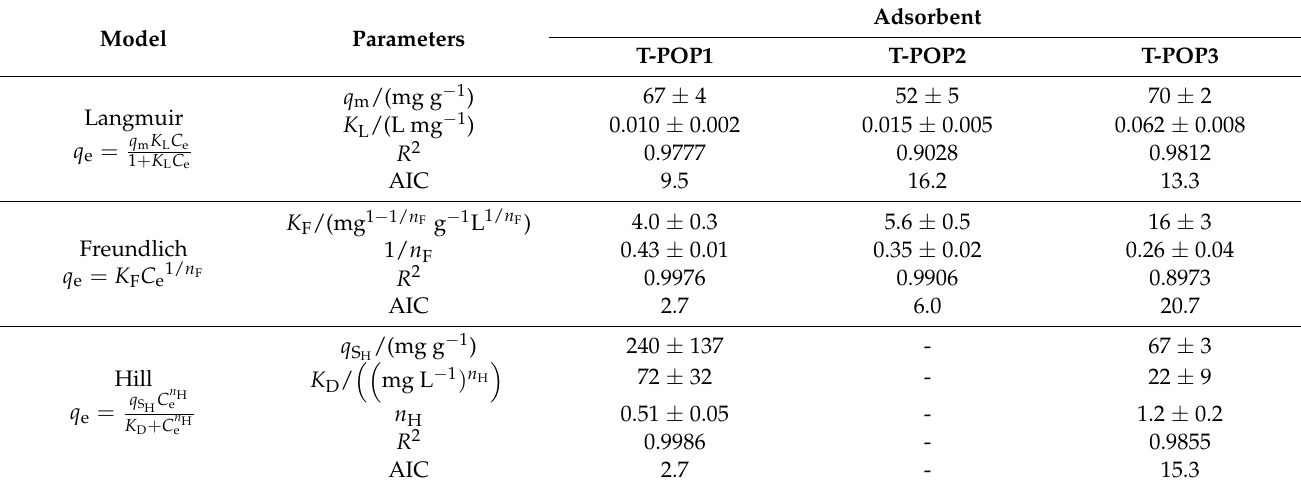
Table 4. Fitting parameters of different models of isotherms for MB adsorption.